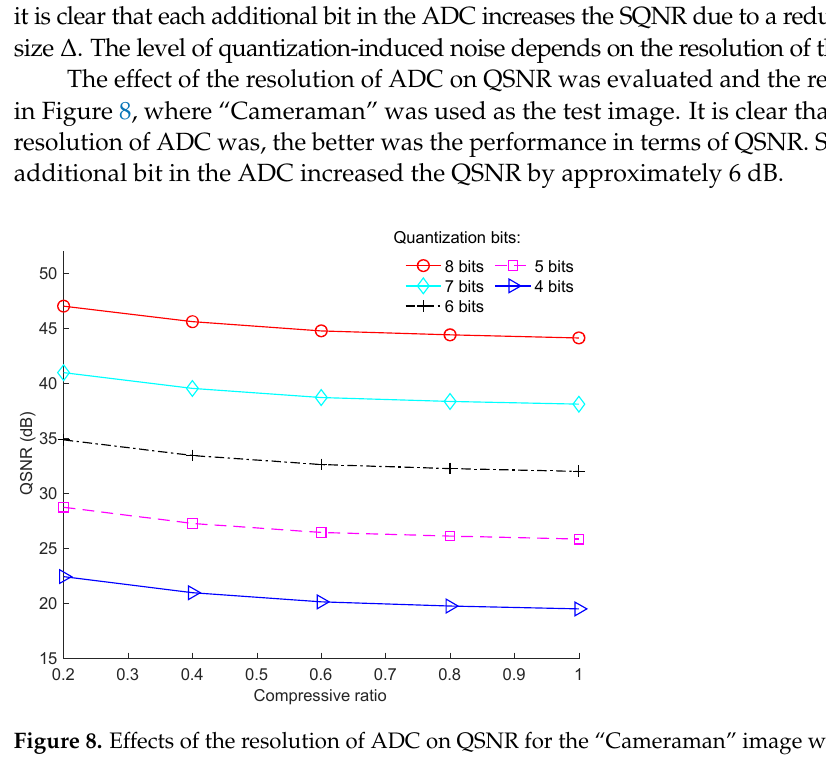
Figure 8. Effects of the resolution of ADC on QSNR for the “Cameraman” image with a block size of 128 ×